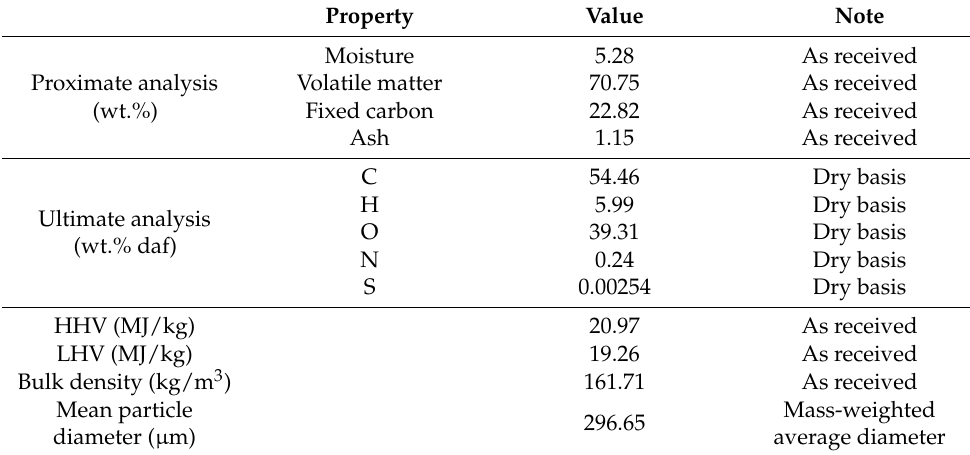
Table 4. Main properties of the torrefied woodchips.